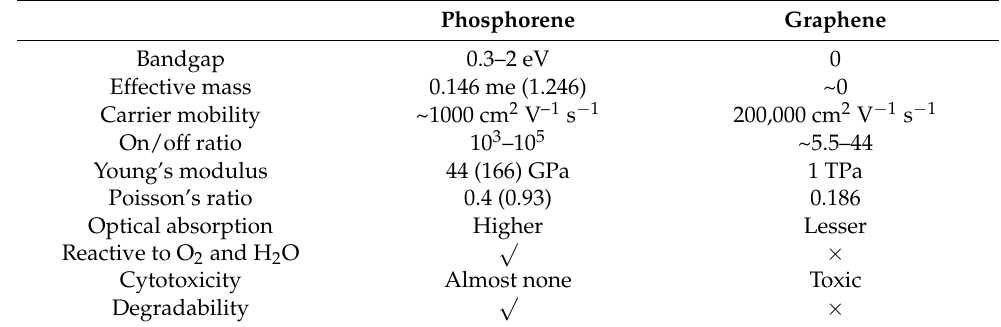
Table 2. A comparison between the properties of phosphorene and graphene.